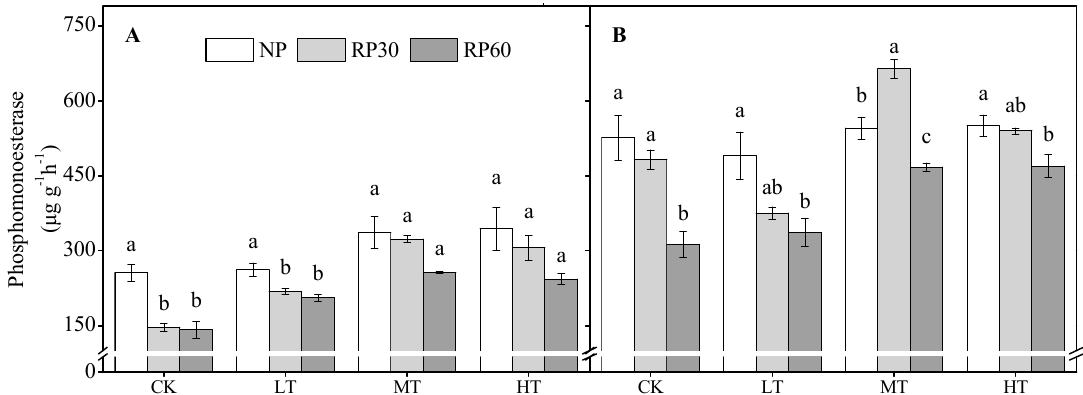
Figure 2. Soil acid phosphomonoesterase (AcPME) activity in the dry ( A ) and rainy ( B ) seasons under different precipitation and thinning treatments in L. principis - rupprechtii plantations. CK, control site; LT, light thinning; MT, moderate thinning; HT, high thinning. NP, natural precipitation; RP30, 30% reduced precipitation; RP60, 60% reduced precipitation. Error bars indicate standard error ( n = 3). Different lowercase letters denote significant differences between precipitation treatments according to Tukey’s test ( p < 0.05).